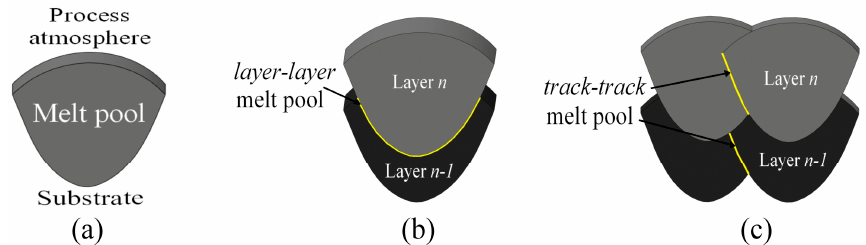
Figure 6. Schematic representation of different types of molten pool boundaries (MPBs): ( a ) single MPB; ( b ) “layer-layer” MPB; and ( c ) “track-track” MPB